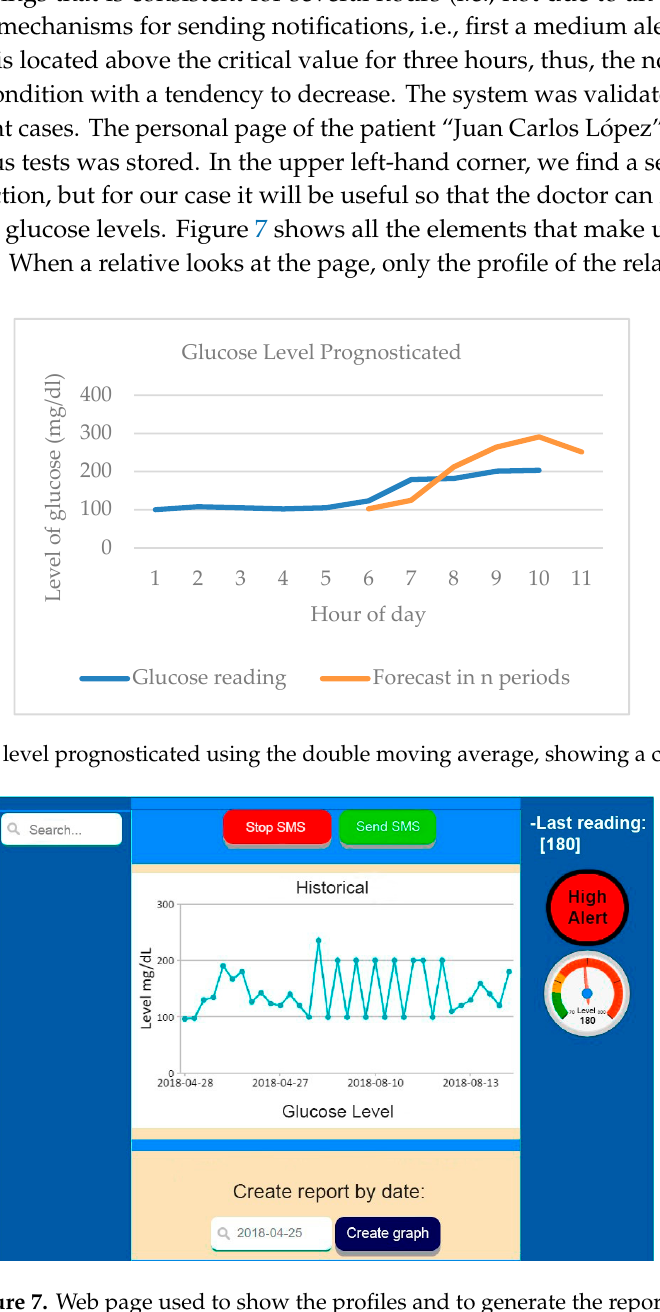
Figure 7. Web page used to show the profiles and to generate the reports.